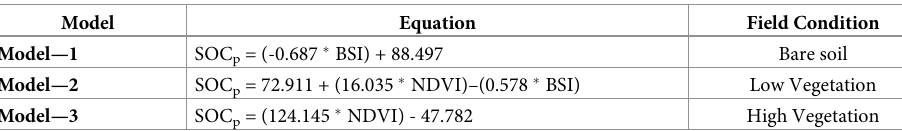
Table 5. SOC-VIs regression